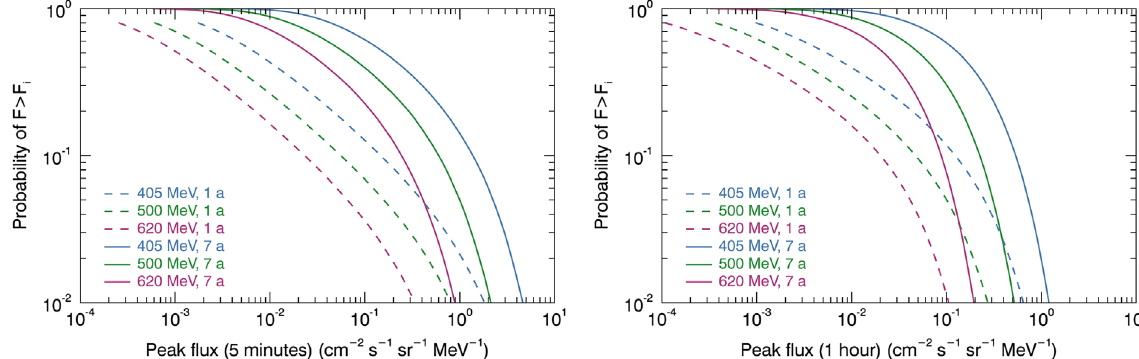
Fig. 5. The probability of exceeding a 5 min (left) and 1 h (right) peak fl ux for one year (dashed curve) and seven year (solid curve) missions.